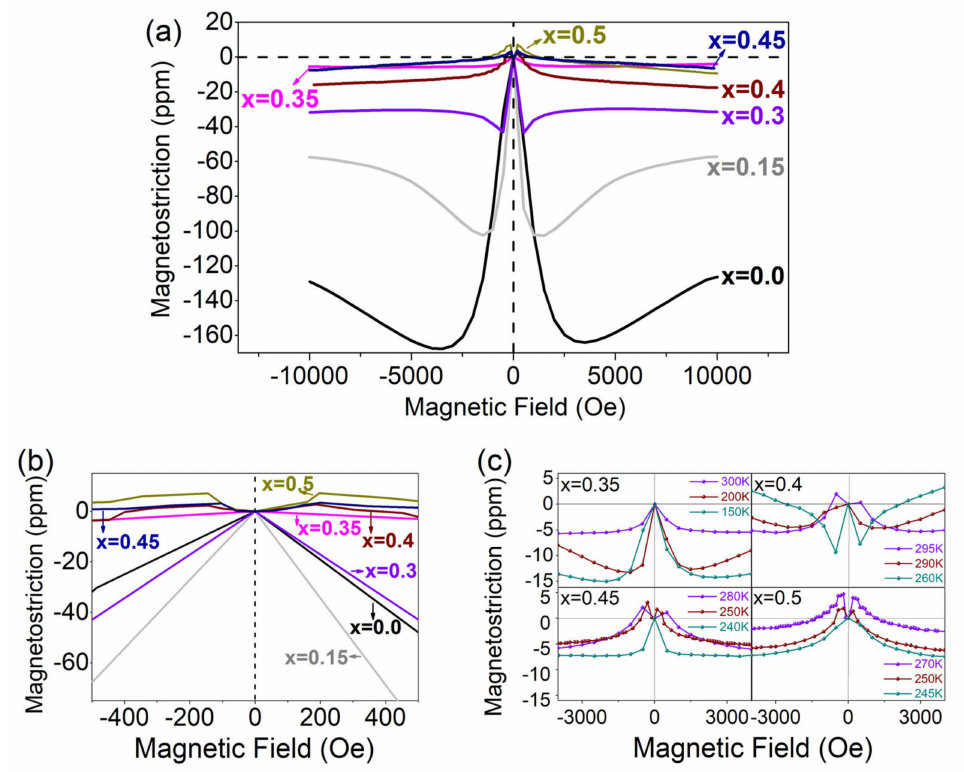
Figure 6. (Color online). ( a ) Magnetostriction curves of Co(Fe 1 − x Al x ) 2 O 4 ( x = 0.0, 0.15, 0.3, 0.35, 0.4, 0.45, 0.5) at 300 K; ( b ) the magnetostriction curves under 500 Oe; ( c ) temperature dependent magnetostriction curves of Co(Fe 1 − x Al x ) 2 O 4 ( x = 0.35, 0.4, 0.45,